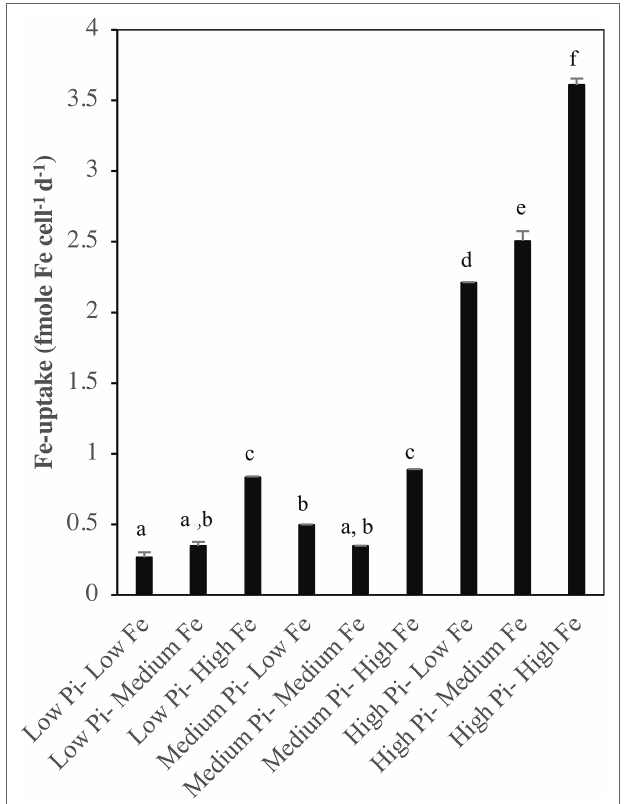
FIGURE 8 | Fe-uptake in Halothece sp. PCC 7418 (fmole Fe cell −1 day −1 ) measured as the difference of the initial Fe concentration and the final Fe concentration at day 10 day of the experiment under [Low represented as Pi. Values are the mean, and the error bar is the spanning range between the duplicate measurements, and letters indicate significant differences ( p < 0.05) between treatments using a post-hoc test (Bonferroni) after ANOVA over the whole dataset was done.